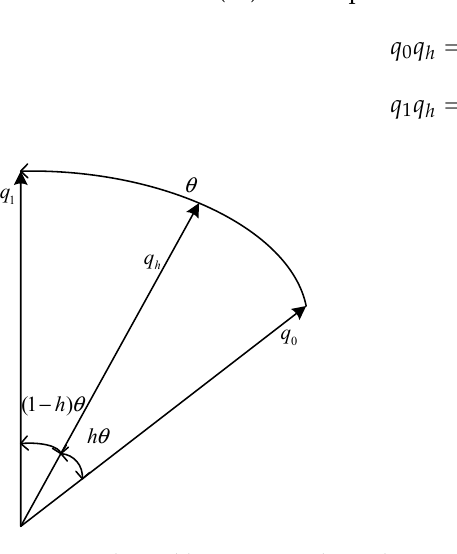
When Formula (34) is multiplied with q 0 and q 1 (as shown in Figure 2), there are: